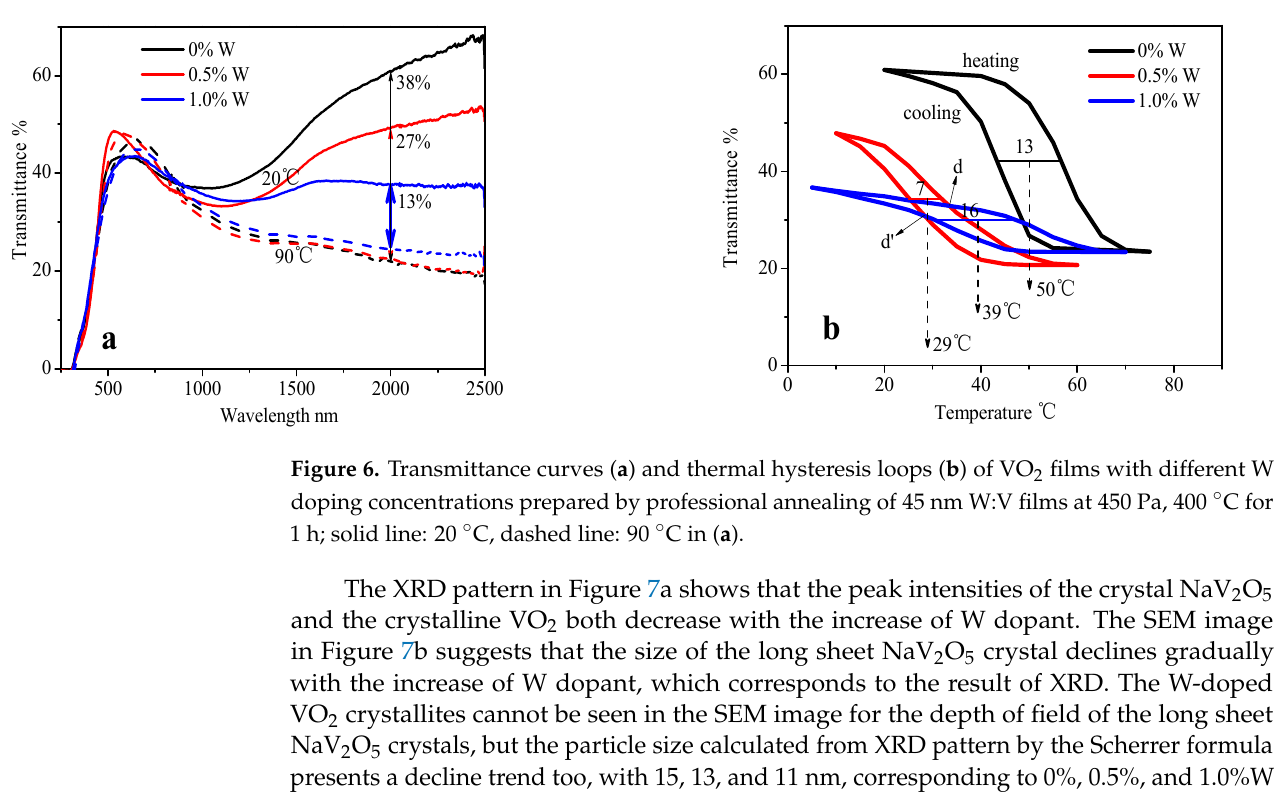
NaV 2 O 5 crystals, but the particle size calculated from XRD pattern by the Scherrer